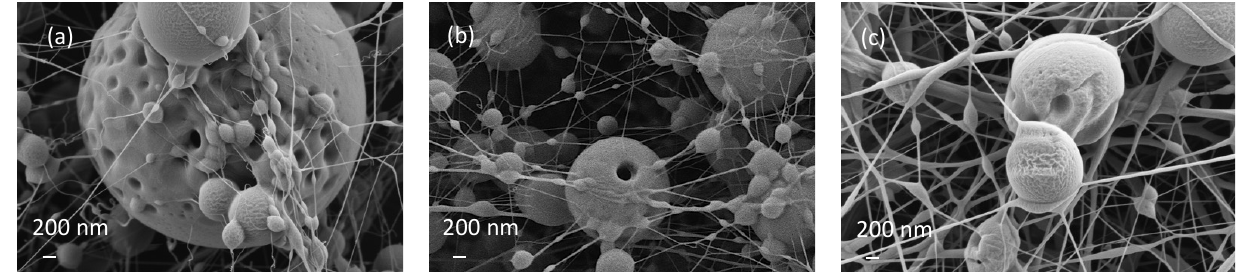
Figure 7. Shell detail from some microspheres.